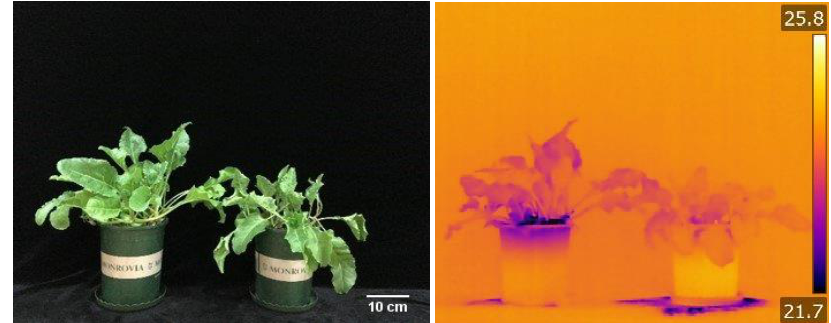
Figure 2. Sugar beet grown for three weeks under control and 300 mM NaCl, normal imaging shows the e ff ect of salinity stress on sugar beet growth ( A ) and thermal imaging indicates higher rates of transpirational cooling in plants under control conditions (B). One (of 5) typical images are shown for each